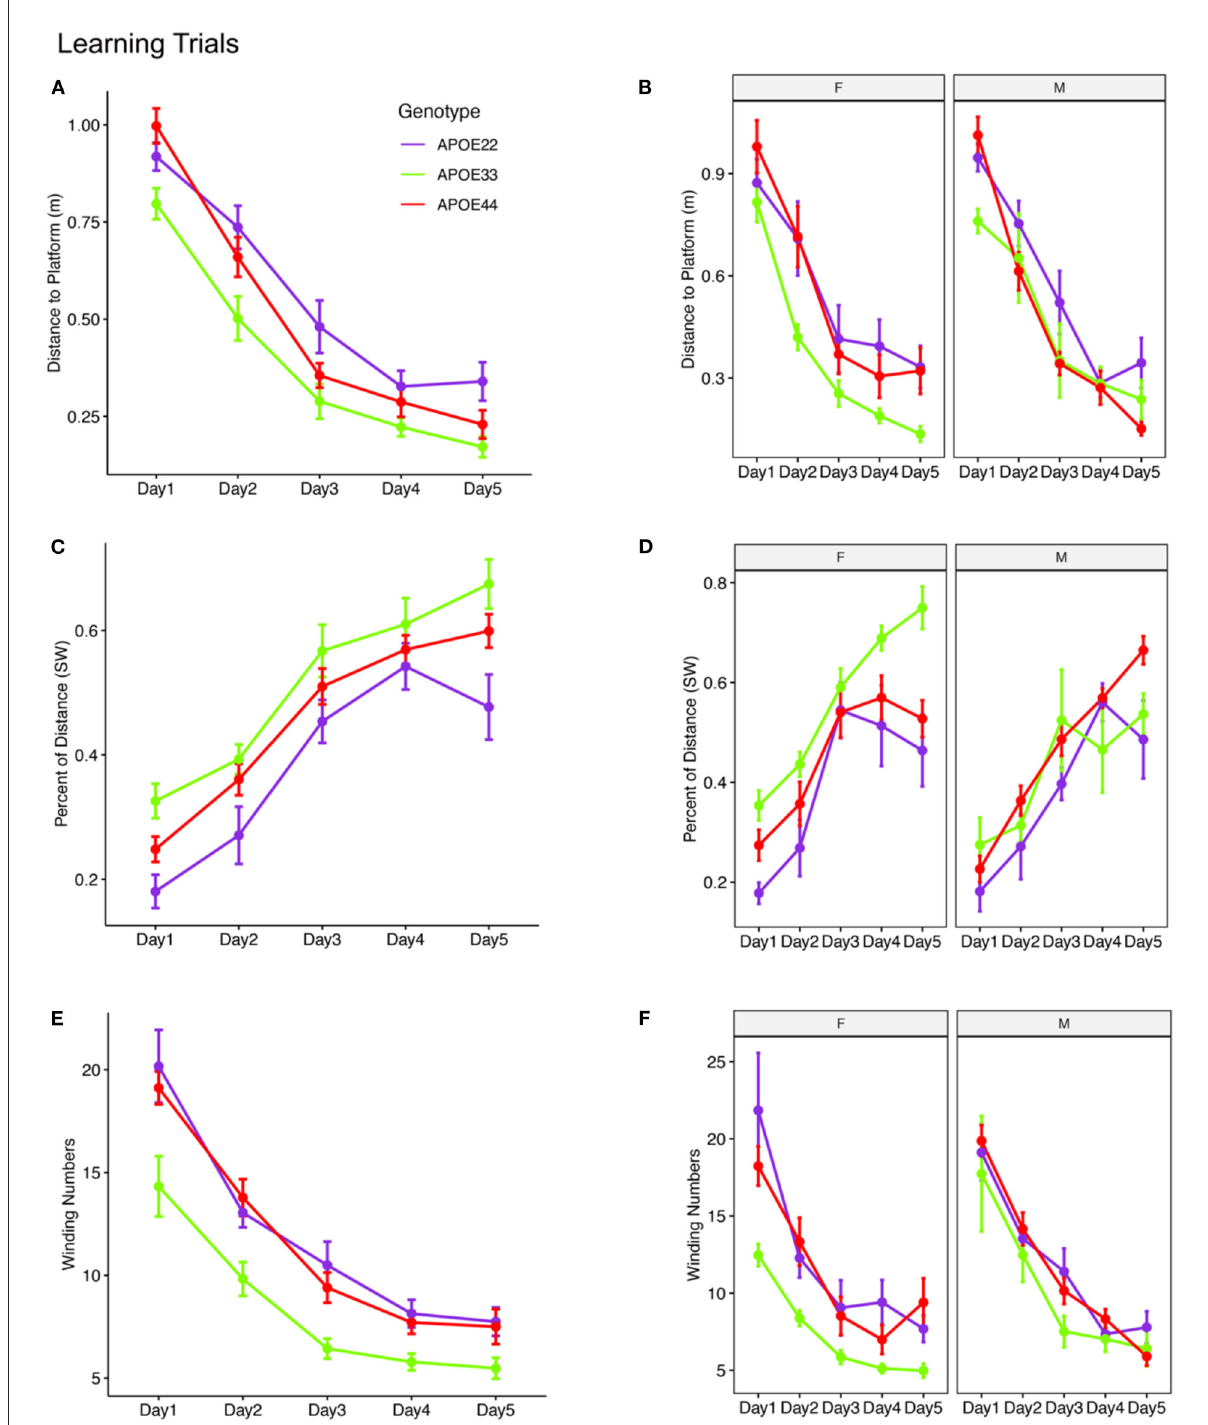
FIGURE2 Learning trials. Mice swam shorter distances over the 5 testing days until reaching the hidden platform, indicating that they were learning (A,B) . Meanwhile, the percentage time swam in the target quadrant increased with time (C,D) . The absolute winding number clearly discriminated the APOE3 mice relative to APOE2 and APOE4 carriers, which used more similarly shaped trajectories (E,F) . The effects were larger in females across the 5 days. F, female; M, male. Graphs show mean ± standard